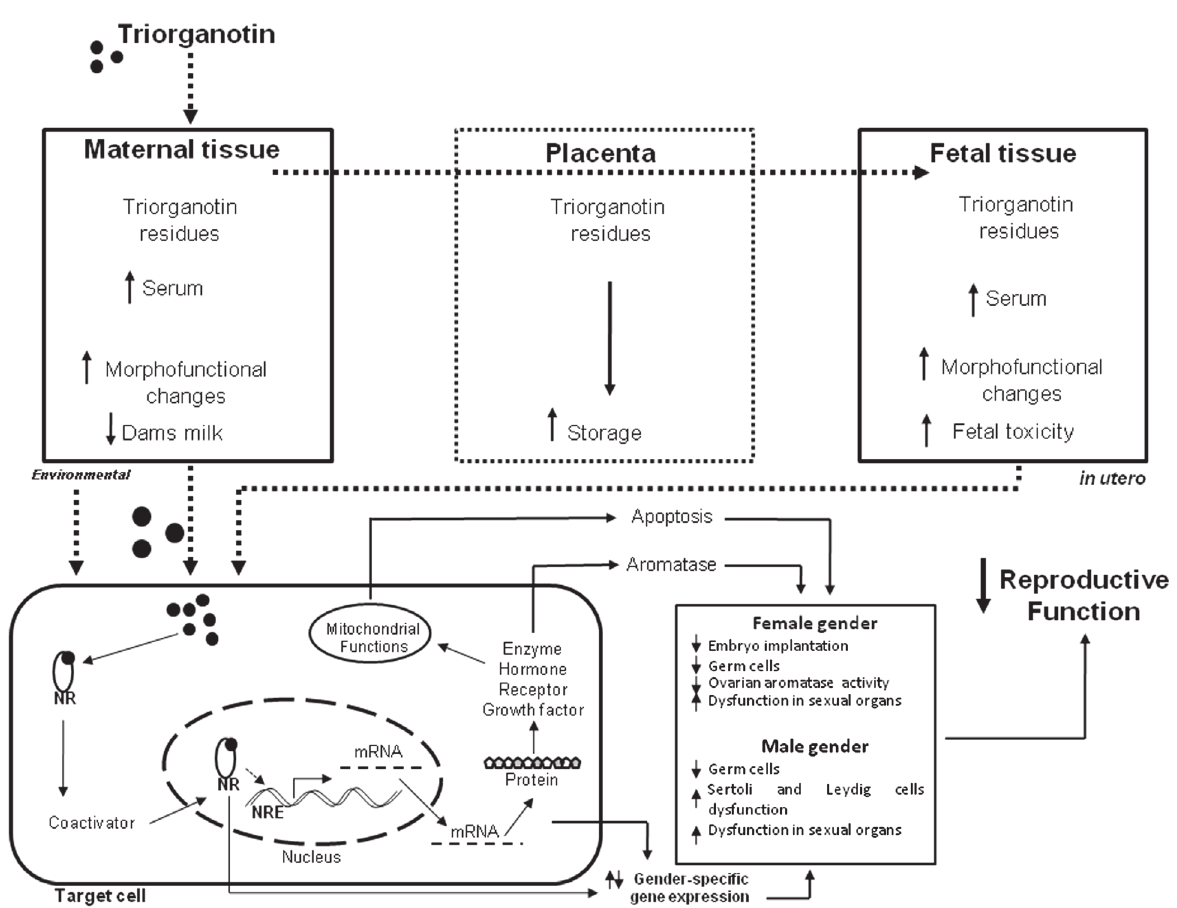
Figure 2. Diagram of triorganotin distribution in the maternal-fetal-placental unit and its effects on signal transduction pathways of cell metabolism affecting reproductive function. NR = nuclear receptor; NRE = nuclear receptor response element. The dashed arrows indicate that triorganotin crosses the maternal-fetal-placental tissues and cell membranes. The continuous arrows indicate a potential signaling pathway through which triorganotin might act to modulate metabolism in target cells and